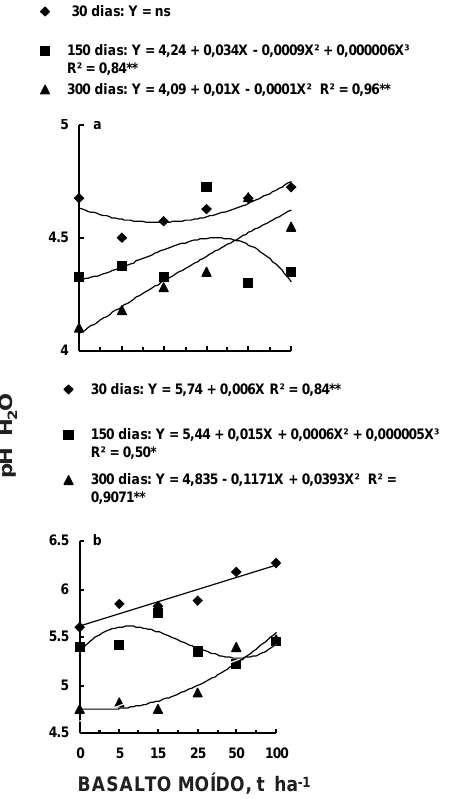
Figura 4. Valores de pH em um Latossolo Vermelho- Escuro (a) e em um Podzólico Vermelho-Amarelo (b), tratados com doses crescentes de basalto moído, após 30, 150 e 300 dias de incubação. Média de rocha.